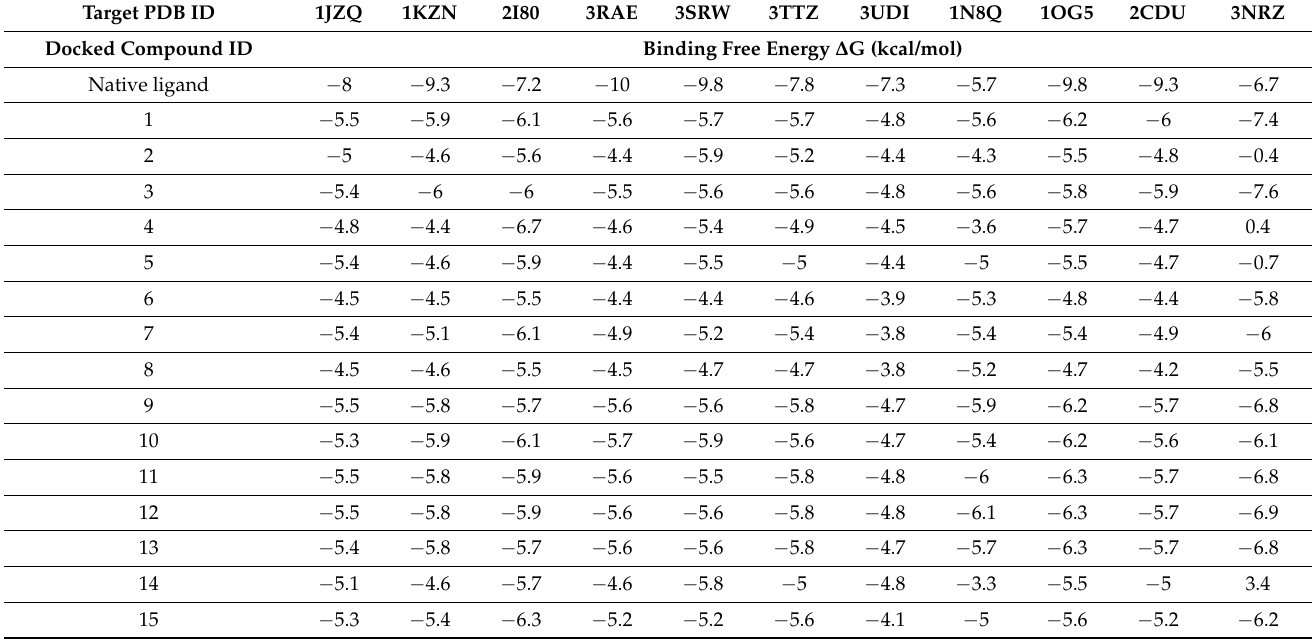
Table 5. Docking scores for compounds 1–39 (binding energy, ∆ G kcal/mol); compounds with better docking scores as compared to the target’s native ligand score are highlighted in